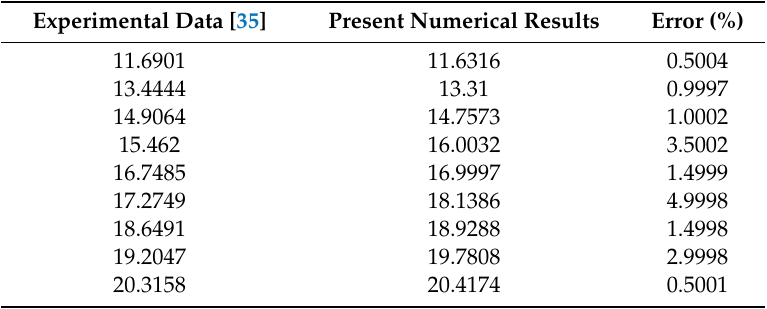
Table 3. Deviation of current numerical results from experimental data [35]. Reproduced with permission from [35]. Copyright Elsevier,